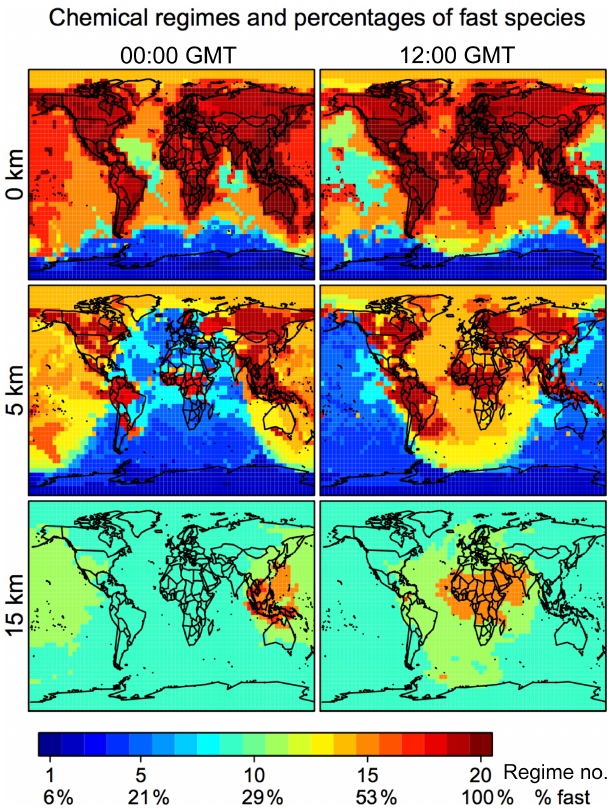
Figure 4. Chemical mechanism complexity needed in different re- gions of the atmosphere. The figure identifies the chemical regime from Table 2 needed to simulate a given GEOS-Chem grid box on 1 August 2013 at 00:00 and 12:00GMT. The percentage of the 228 species treated as fast (requiring coupled implicit solution) in that chemical regime is shown on the color bar and more details are in Tables 1 and 2. Results are shown for different altitudes and using a threshold δ of 100moleculescm − 3 s − 1